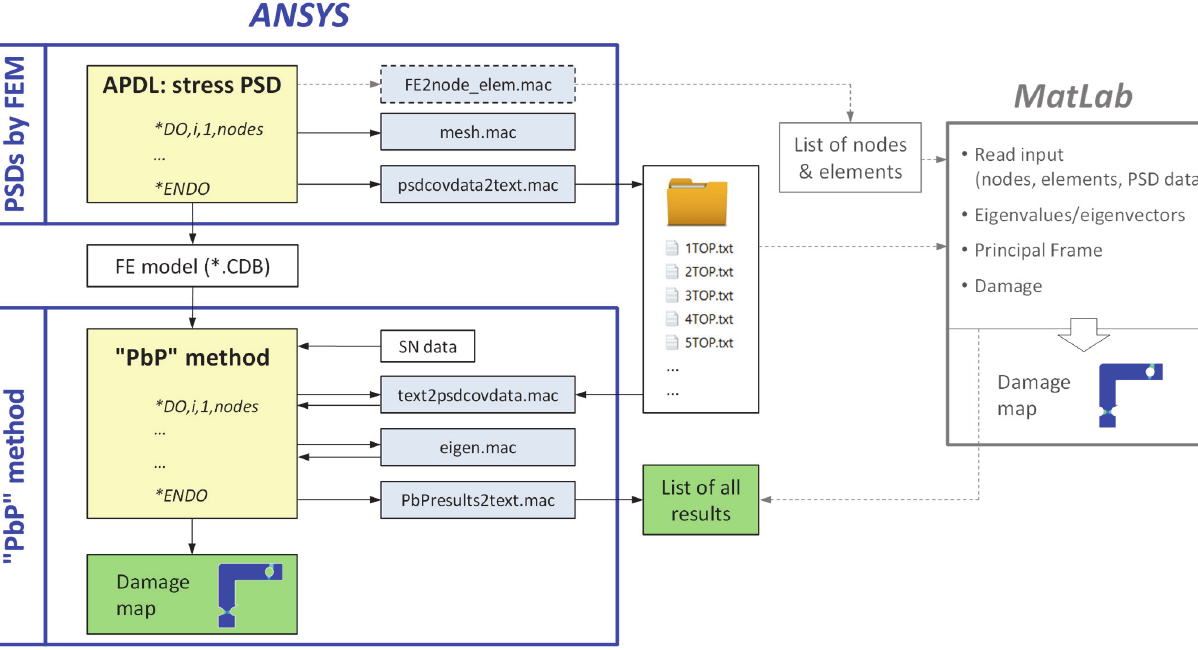
Figure 10: Flowchart of the APDL script to implement the PbP in Ansys software. The relationship with the previous Matlab-based procedure (sketched on the right) is